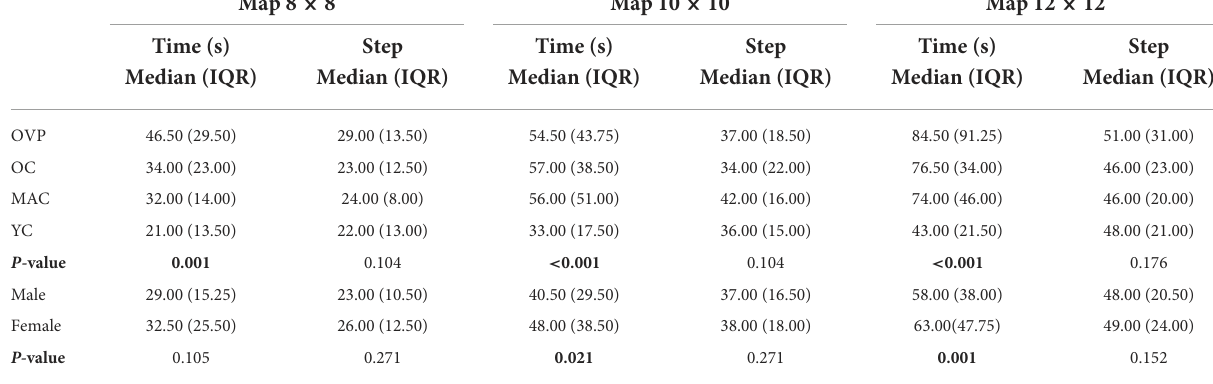
TABLE 3 Comparison of maze test indexes between groups.